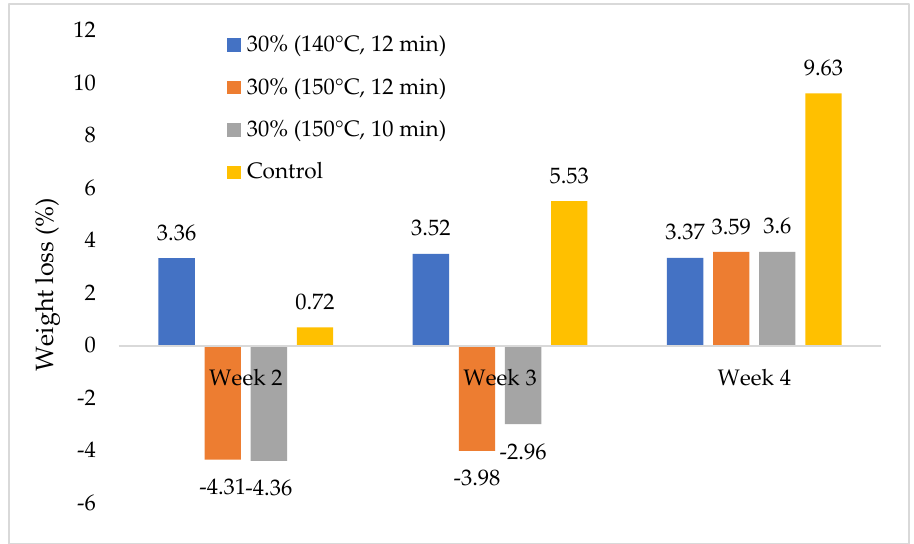
Figure 7. Weight loss of samples after 2-, 3-, and 4-weeks exposure to subterranean termites.